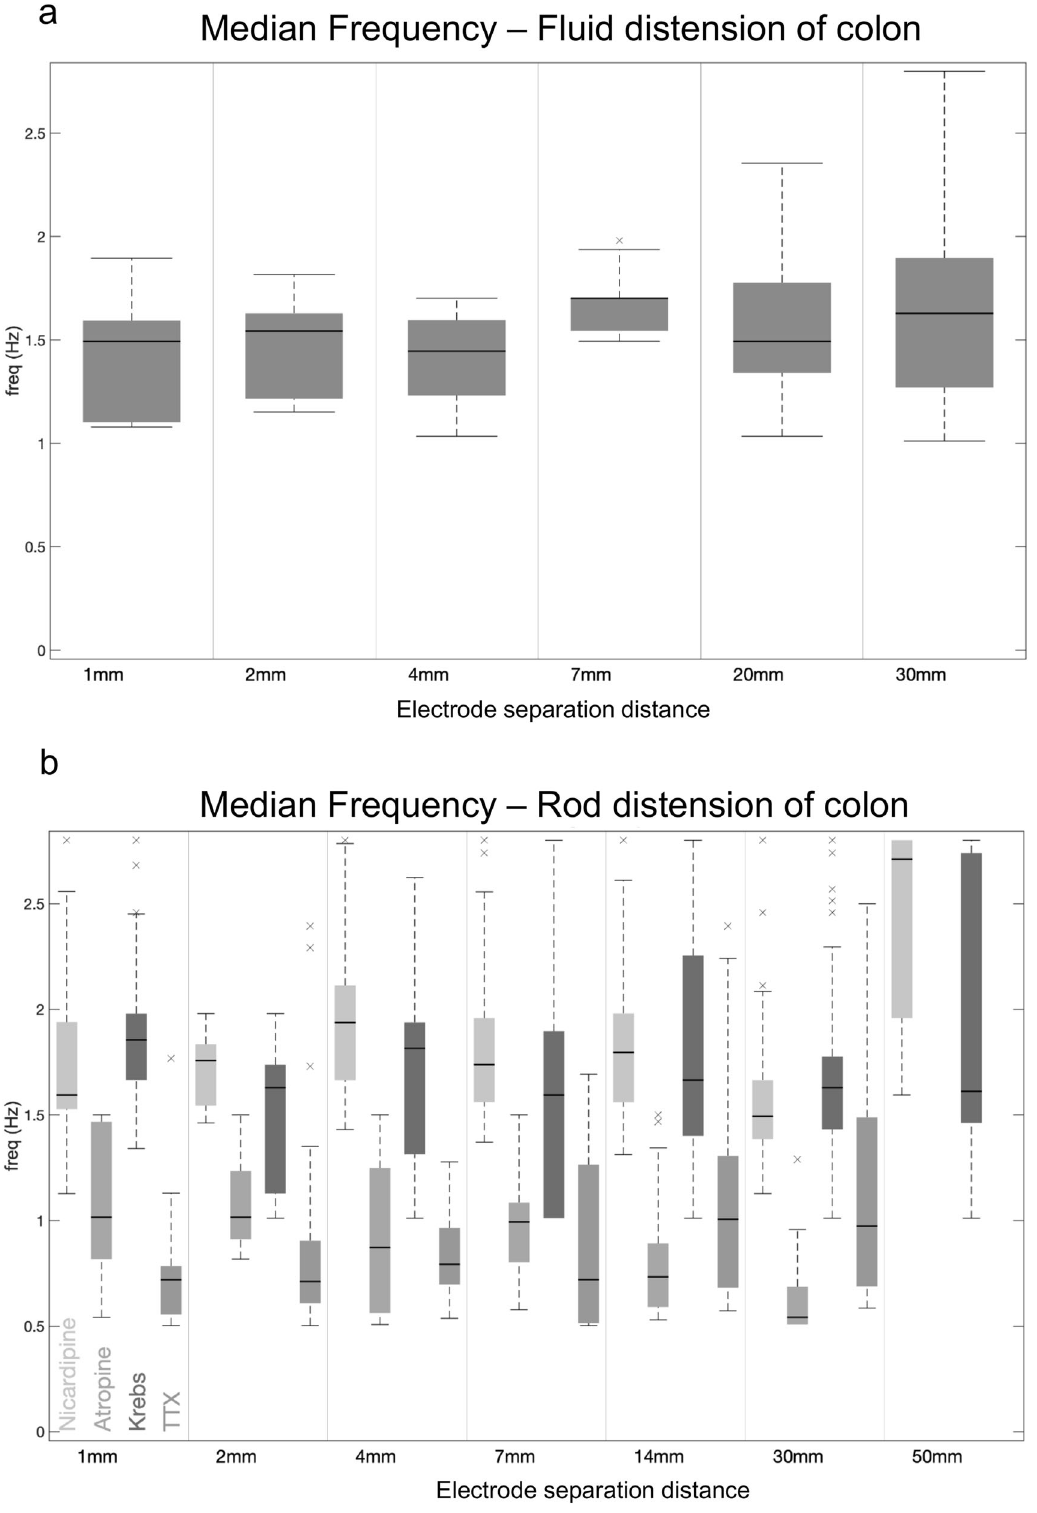
Fig. 4 Median frequency of EJPs during propulsion elicited by fl uid distension and rod distension. a In response to fl uid distension, boxplots show the distribution of the median frequency (during activity) as measured by the CWT, for the range of distances considered. b In response to rod distension, boxplots show the distribution of the median frequency (during activity) as measured by the CWT. In atropine, the coordinated IJPs occur at lower frequencies to the EJPs in nicardipine or normal Krebs